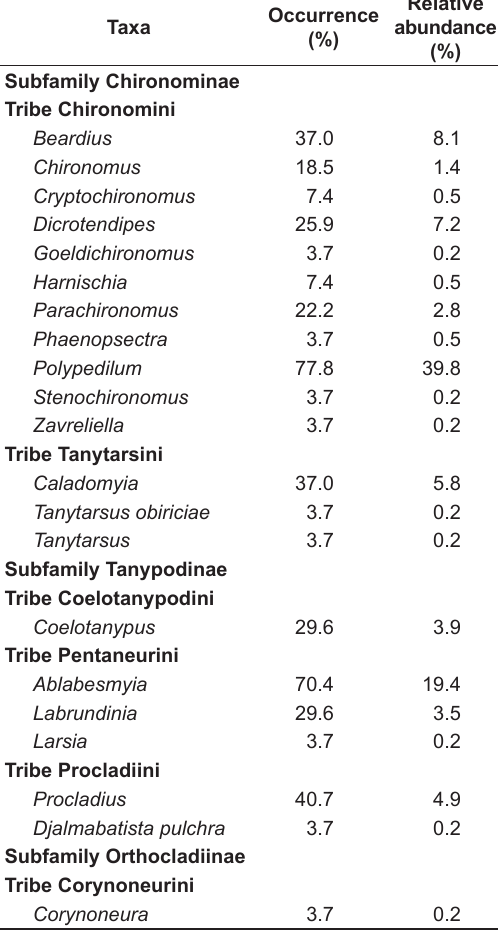
Table 1. Percentage of occurrence and relative abundance of 21 Chironomidae genera in 26 plots in February 2007 at the Long-Term Sampling Site (LTSS), Pantanal,